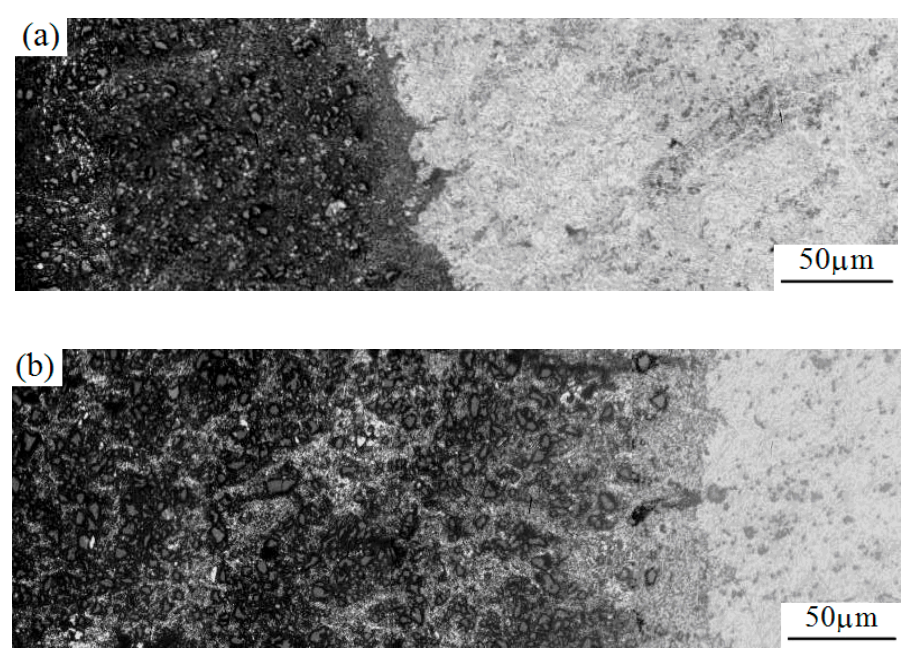
Figure 3. Microstructure of the transition zone of alloy ingots of the Al–50Pb system in ( a ) the initial state and ( b ) after EMP treatment. The light field is the aluminum phase, and the dark field is the lead phase.